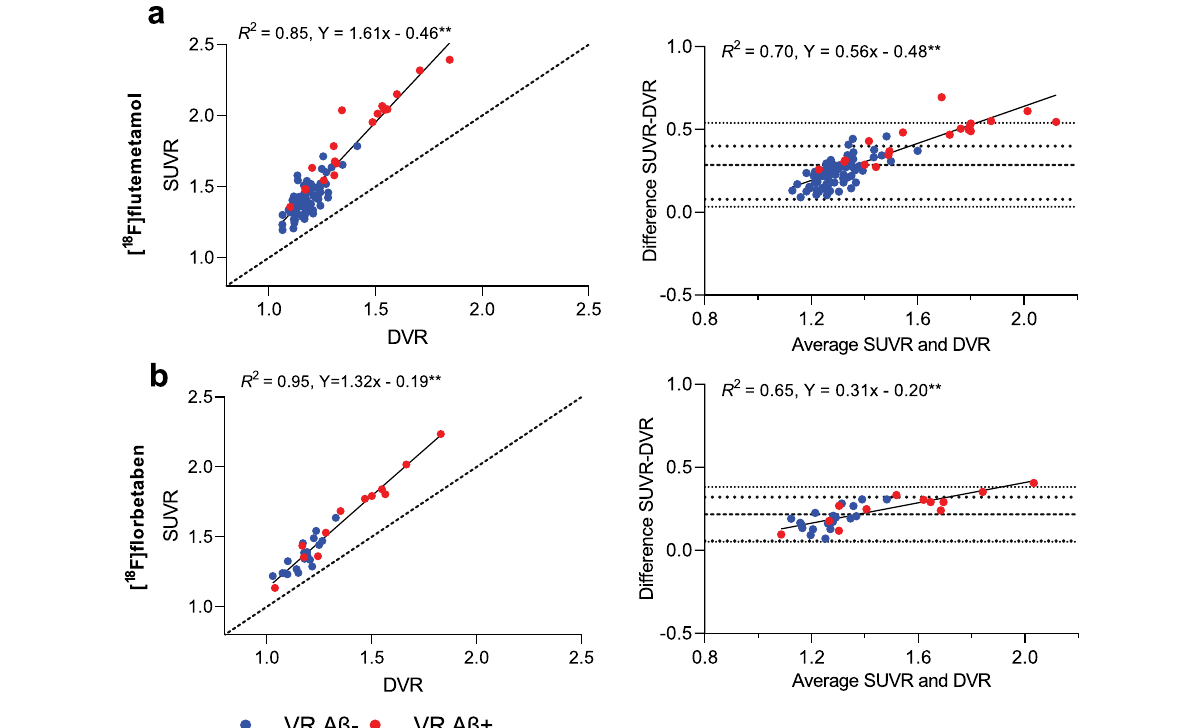
Fig. 2 Relationship between DVR and SUVR. Correlation and Bland–Altman plots to assess the relationship between global cortical DVR and SUVR for a [ 18 F]flutemetamol and b [ 18 F]florbetaben. Dotted lines corresponds to 95% Limits of Agreement. ** p < 0.001, VR: visual read